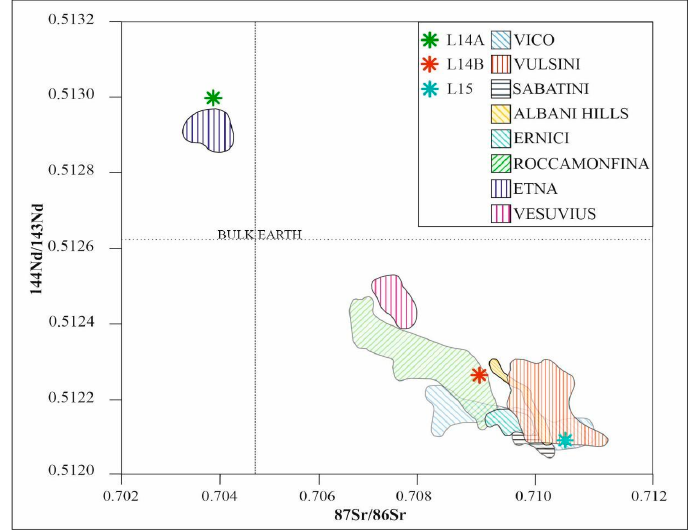
Figure 6. Radiogenic Isotopic Sr/Nd diagram